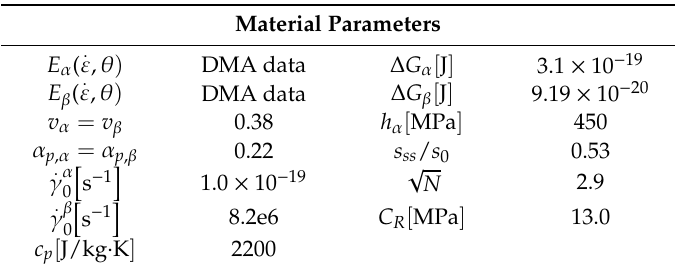
Table 5. Initial parameters for the MB model applied to PVC